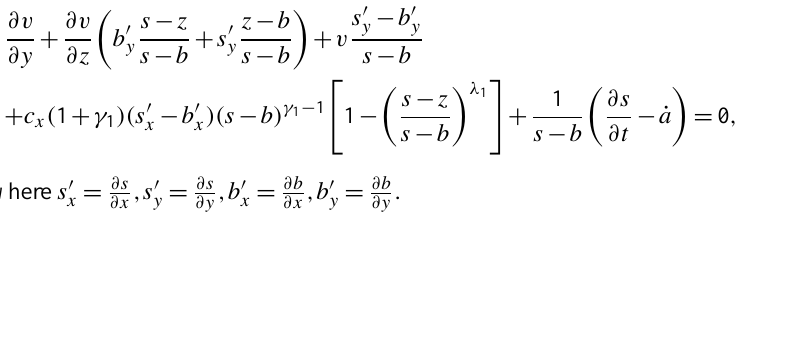
Fig. 7. 3-D time-dependent experiment. The left and right graphs show the ice surface x - and y - horizontal velocity respectively at the beginning. At the time when the steady-state solution is reached, both velocities at the surface are uniform and have values of 46km/yr. Substituting (54) and (55) into (52) and using relations ∂b differential equation with four independent variables ( x , y , z , and t ) and only one dependent variable ( v